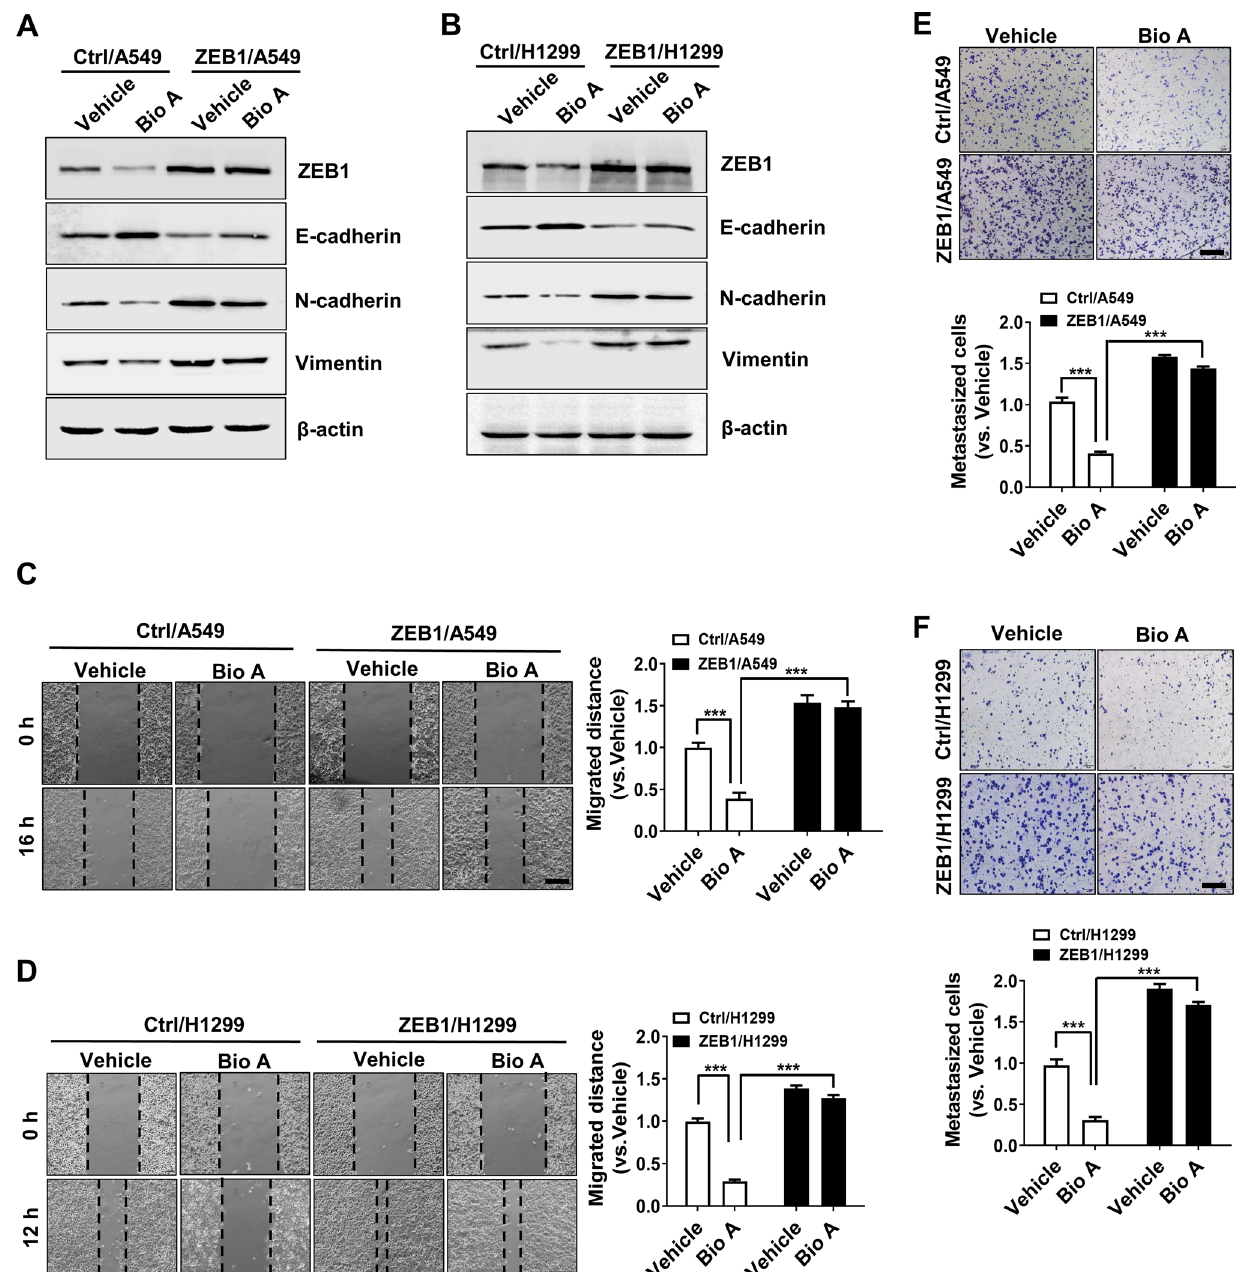
Fig. 4 Biochanin A inhibits lung adenocarcinoma metastasis in a ZEB1-dependent manner in vitro. Immunoblotting of EMT markers in A549 ( A ) and H1299 ( B ) cells in the presence or absence of Biochanin A. Wound-healing assay in ZEB1-expressing A549 ( C ) and H1299 ( D ) cells in the presence or absence of Biochanin A. Scale bars, 100 μm. *** P < 0.001 vs. respective controls by an unpaired Student’s t -test. Transwell assay in ZEB1-expressing A549 ( E ) and H1299 ( F ) cells in the presence or absence of Biochanin A. Scale bars, 100 μm. *** P < 0.001 vs.